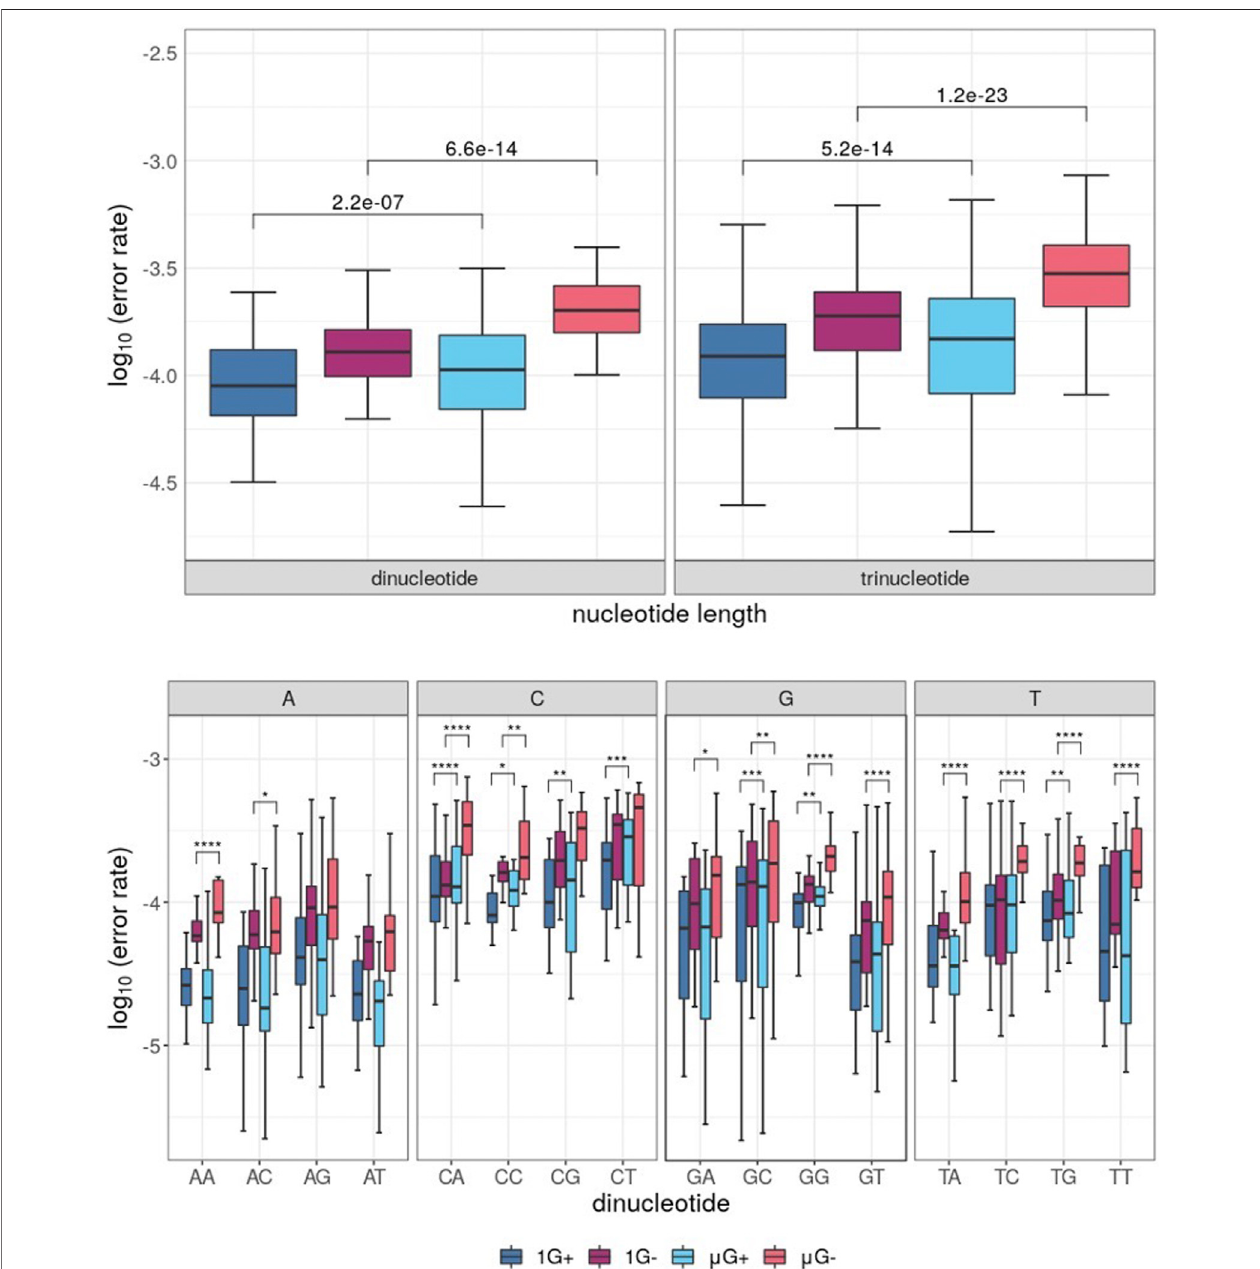
FIGURE 5 | Boxplots of error rates by di- and trinucleotides for each sample under conditions of either earth-like gravity (1 G) or microgravity ( μ G) with + and – referring to the presence or absence of exonuclease activity in the Klenow fragment polymerase, with boxes colored according to Figure 3 . Wilcoxon signed-rank test p -valuesymbolsareshownplottedforeachsigni fi cantcomparison( p < 0.05 (cid:1) *, p < 0.01 (cid:1) **, p < 0.001 (cid:1) ***, p < 0.0001 (cid:1) ****). (A) Boxplotofsubstitutionerrors(log 10 ) fordi-and trinucleotidesforeachtestsample. (B) Boxplotsofdinucleotideerrorratesgroupedbydinucleotideidentity,clusteredbytheidentityofthe fi rsttemplate base for a given dinucleotide